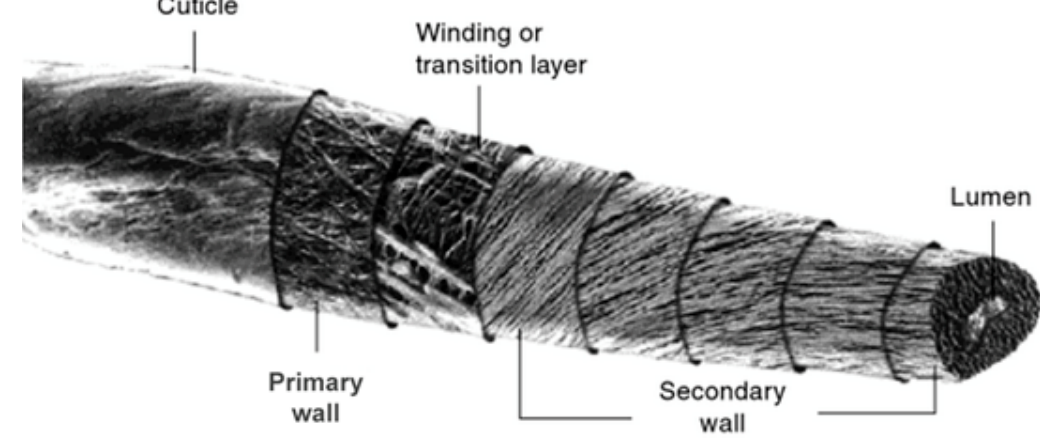
Figure 1. Macroscopic components of the cotton fiber.